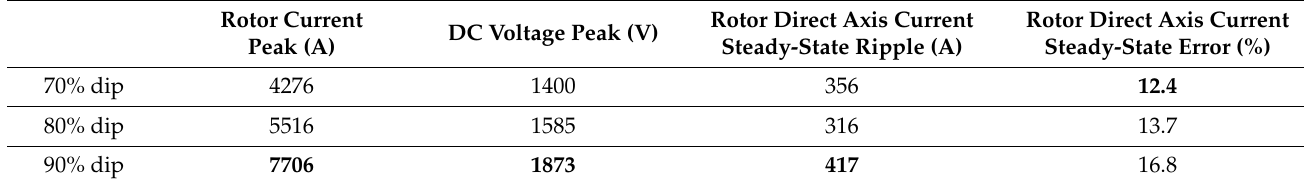
Table 12. Summary of results for LQR applied subject to 3% grid frequency